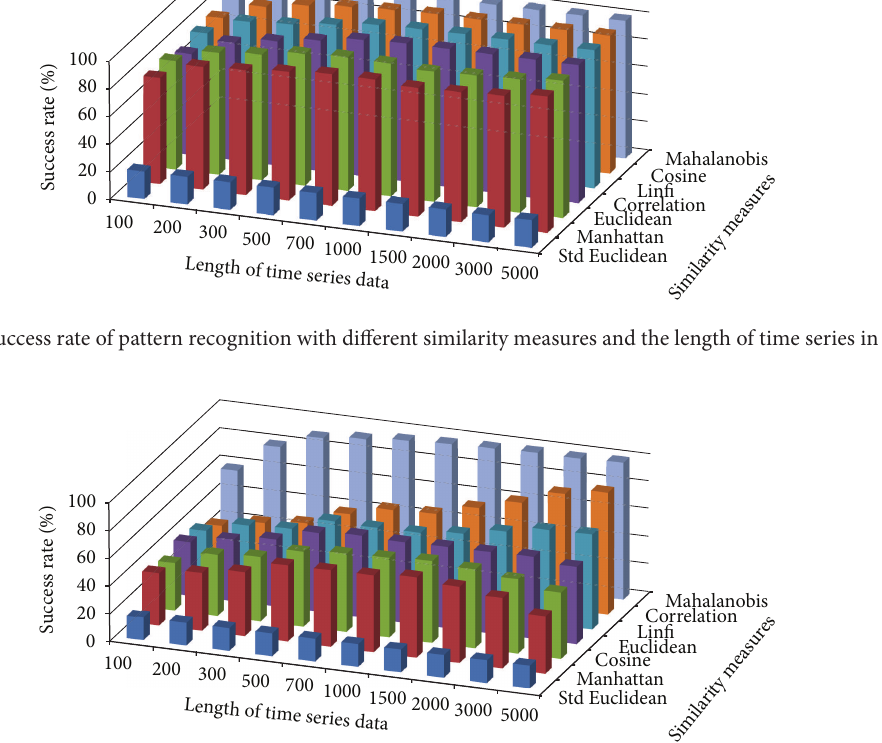
distance outperforms over other similarity measures.